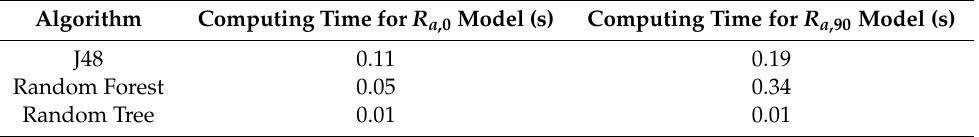
Table 10. Time used by each algorithm to build and validate the model.